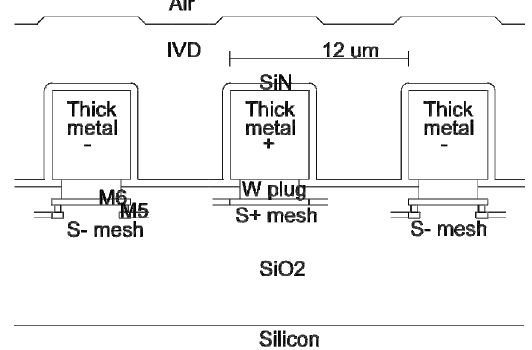
Figure 1. Side-view cross-section of the humidity